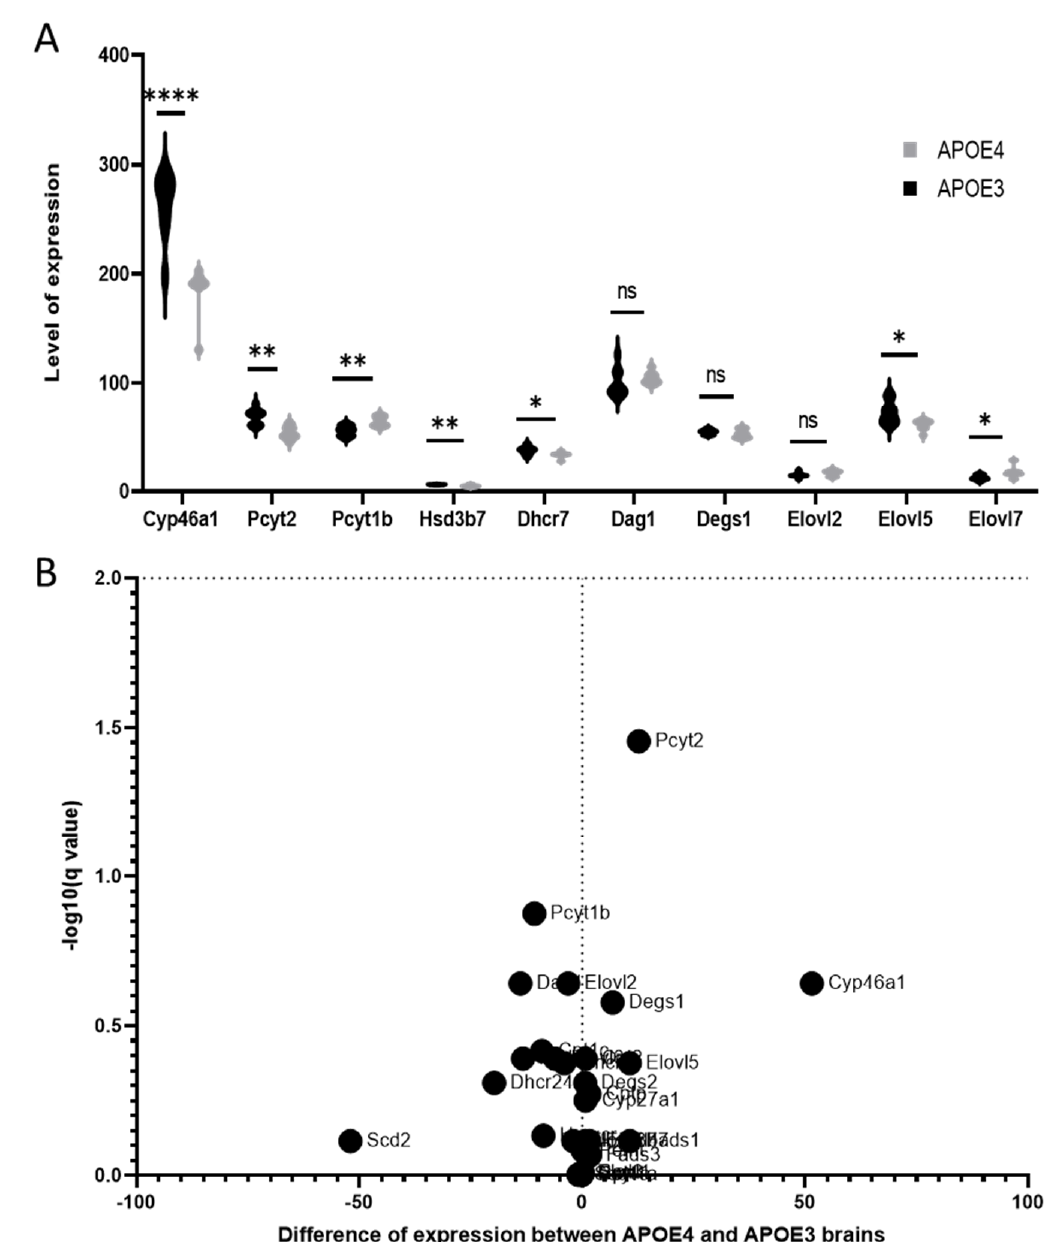
Figure 4. Gene expression of enzymes involved in lipids pathway in the brain of KI mice carrying the human APOE3 or APOE4 alleles [31]. ( A ) Level of expression analysis with multiple unpaired t -test *: p < 0.05, **: p < 0.01, and ****: p < 0.0001. ( B ) Volcano plots.